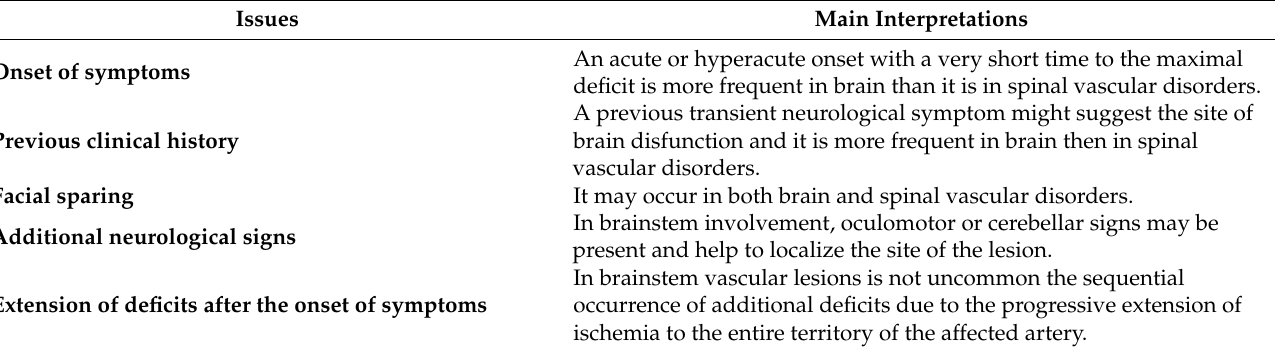
Table 7. Clinical hints for cerebrovascular vs. spinal cause of acute onset quadriplegia.